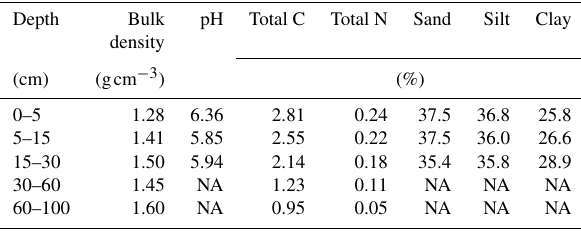
Table 1. Soil characteristics measured at the establishment of the experiment.